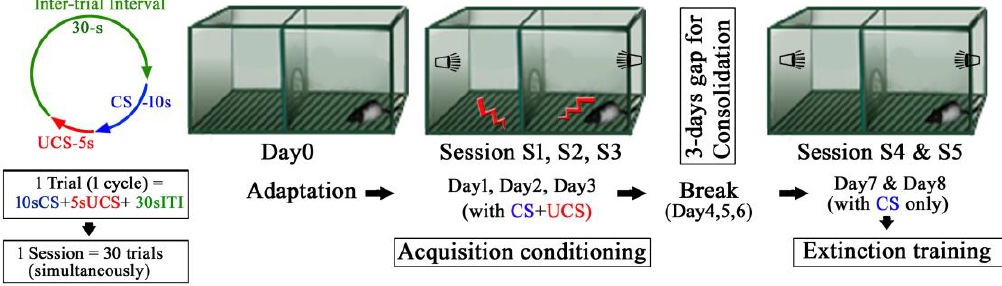
Figure 4. Experimental protocol of the training sessions. Each session consisted of 30 trials with 30 s inter-trial intervals.